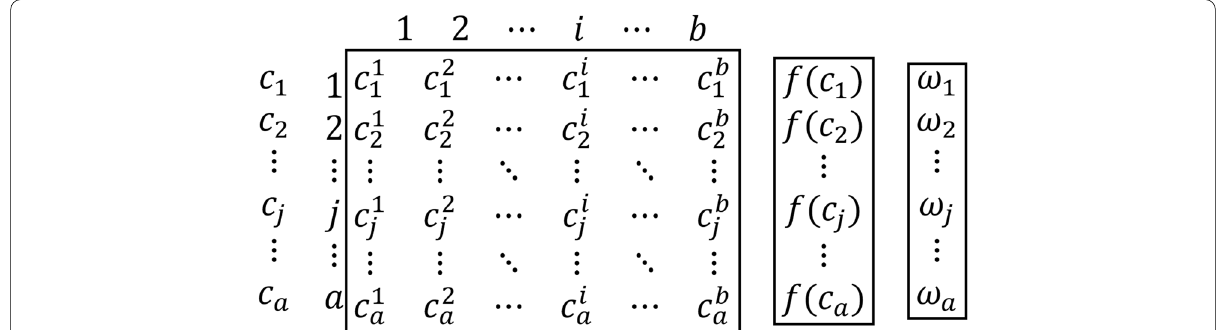
Fig. 3 The structure of parameter